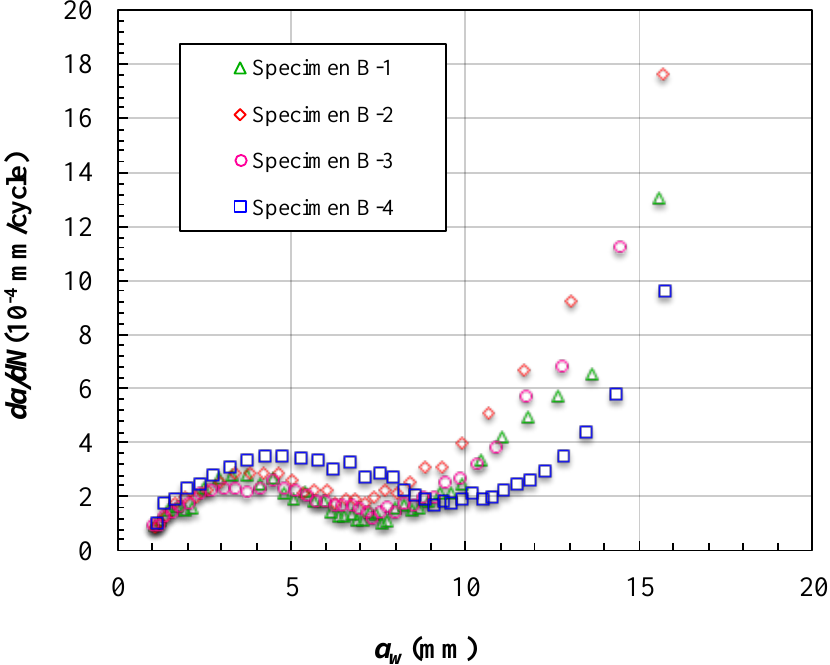
Figure 14. Crack length a w vs loading cycles N of specimens of Group B.